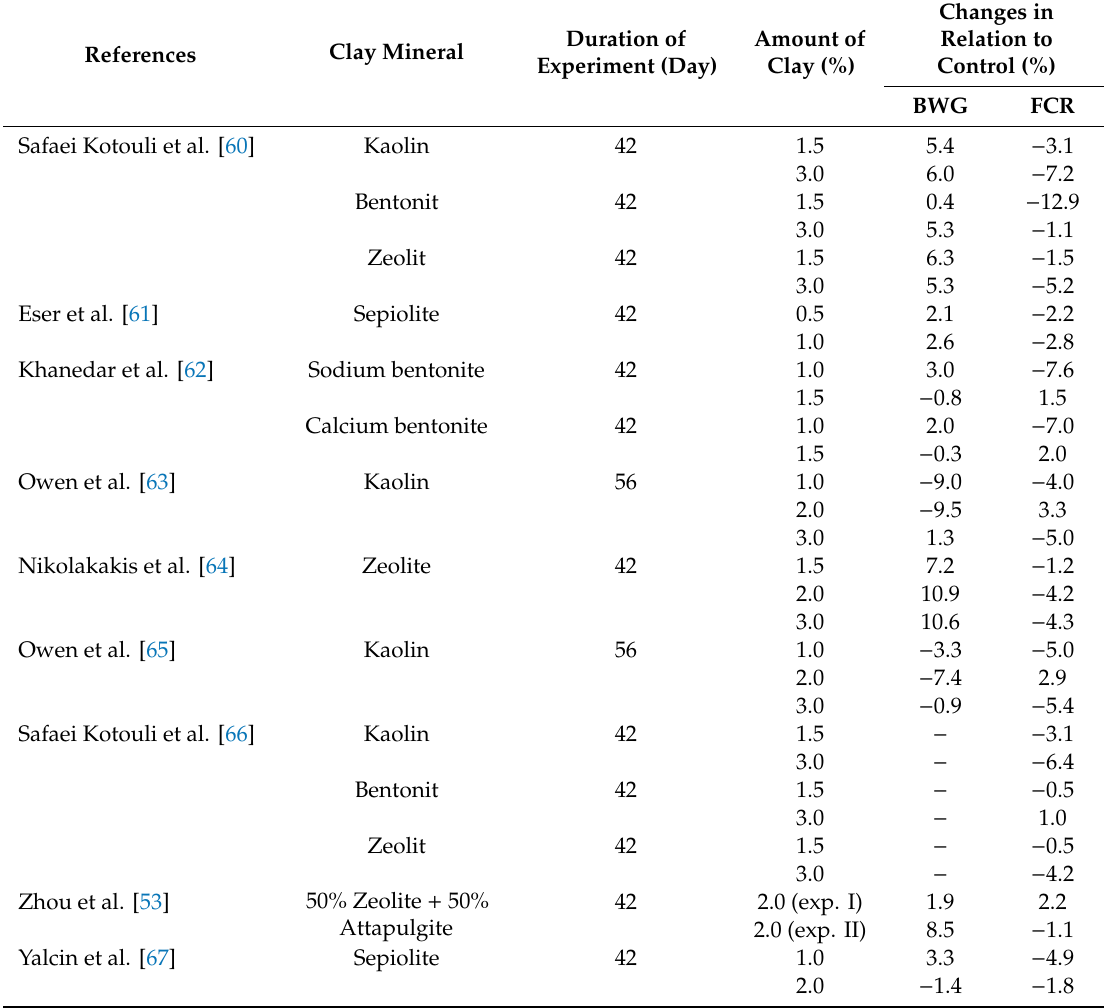
Table 1. The e ff ect of clay mineral additive on total body weight gain (BWG) and feed conversion ratio (FCR) changes of broiler